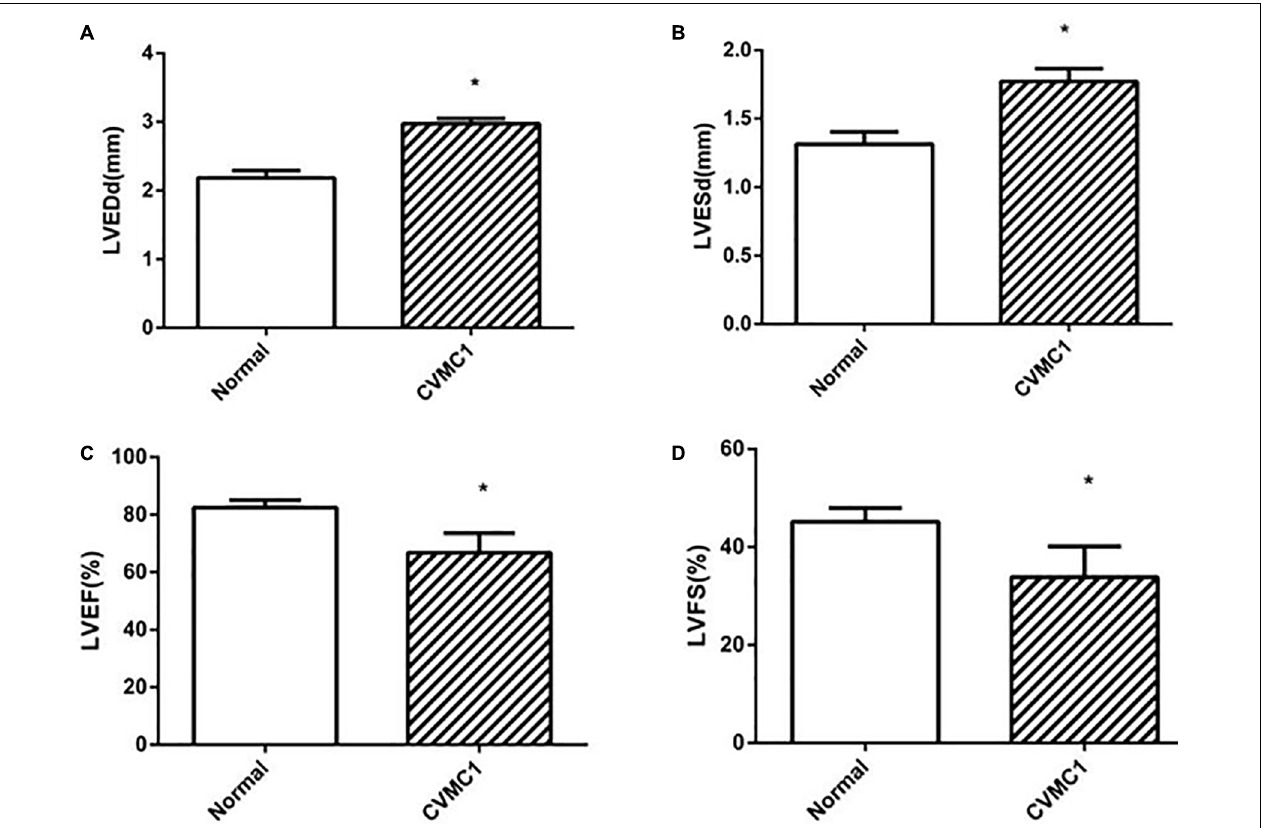
FIGURE 2 | The echocardiography results in Normal control 1 group ( n = 8) and CVMC1 group ( n = 8) on the 42nd day. The LVEDd and LVESd were significantly dilated and the LVEF and LVFS in CVMC1 group were significantly lower than those of normal control group on day 42. (A) LVEDd = left ventricular end diastolic dimension, (B) LVESd = left ventricular end systolic dimension, (C) LVEF = left ventricular ejection fraction, and (D) LVFS = left ventricular shortening fraction. ∗ P < 0.05 vs. Normal (Normal control 1